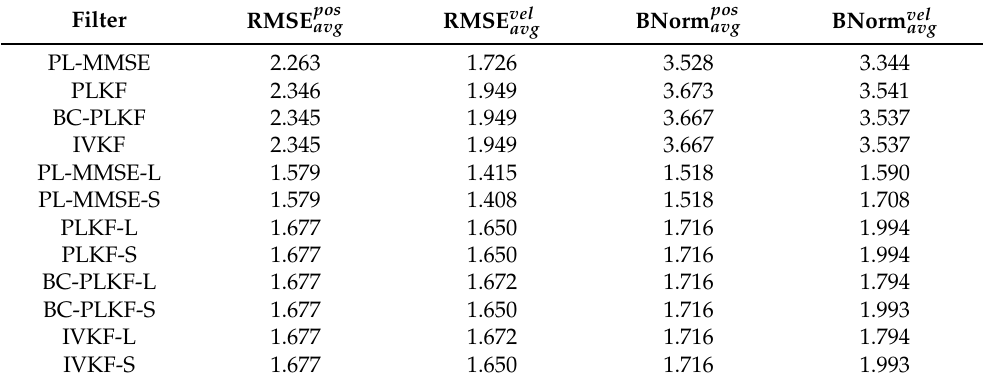
Table 7. RMSE pos avg ( × 10 − 4 m ) , RMSE vel avg ( × 10 − 5 m ) , BNorm pos avg ( × 10 − 5 m ) and BNorm vel avg ( × 10 − 6 m ) of different filters for σ θ = 7 ◦ at V = 10 − 4 m/s on the arc section.